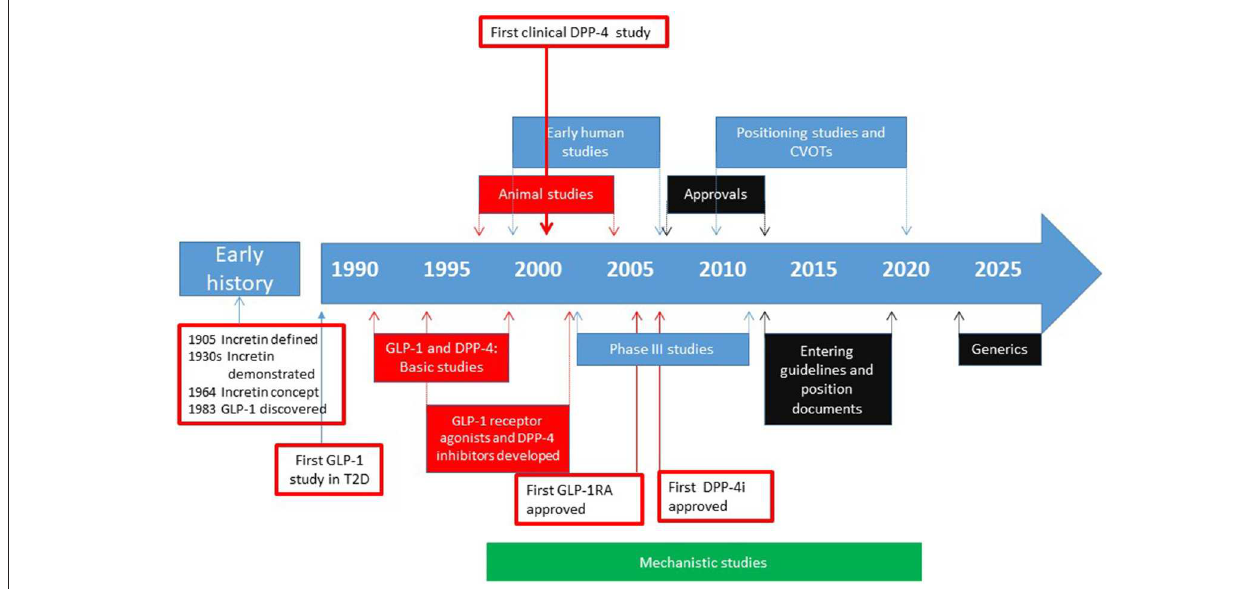
FIGURE 1 | Approximate time line for the different phases in the path to clinical proof for DPP-4 inhibitors. The early history includes discovery and definition of the incretin concept and the discovery of GLP-1. The development of clinically therapy started with the idea that GLP-1 is a potential glucose-lowering agent. The development then went through establishing the structure and function, discovery of different DPP-4 inhibitors and their use in animal studies and early human studies. Then the phase III studies were performed followed by approval of DPP-4 inhibitors for use in patients with type 2 diabetes by FDA and EMA. Thereafter, post-approval positioning studies and cardiovascular outcome trials (CVOTs) were undertaken and the DPP-4 inhibitors entered guidelines and position documents. For future, generics will be introduced in the early 2020s which will reduce the cost of the therapy. In parallel with this development, mechanistic studies have been undertaken in both animals and humans, to establish the mechanism of action of DPP-4 inhibitors and effects of the compounds beyond their glucose-lowering action. Basic and experimental animal studies are shown in blue, human studies in red, regulatory phases in black and mechanistic studies (performed in vitro , in animals and in humans) shown in green. Arrows indicate approximate years for the various